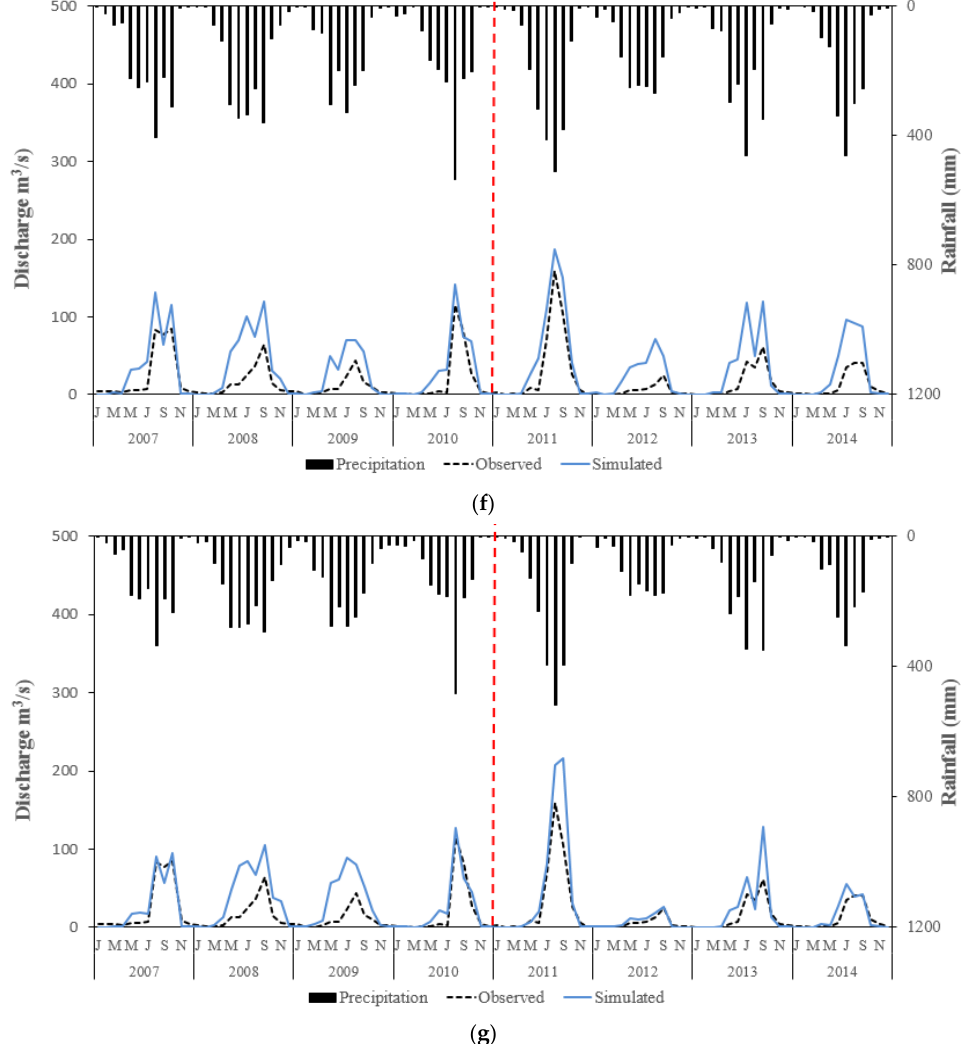
Figure A1. ( a ) For PERSIANN; ( b ) For CCS; ( c ) For CDR; ( d ) For MSWEP; ( e ) For CHIRPS; ( f ) For IMERG; ( g ) For APHRODITE V1801.